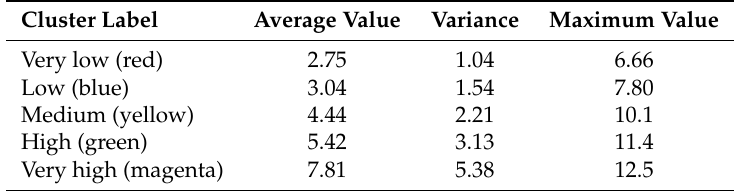
Table 6. Fuel consumption (L/100km) parameters of the five-cluster